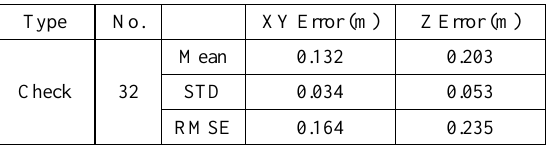
Table 3. Summary of spatial error in direct georeferencing